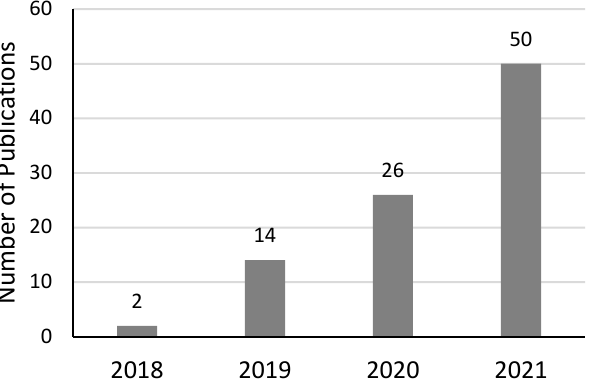
Figure 2. Blockchain and smart contract publications through the years in construction engineering.